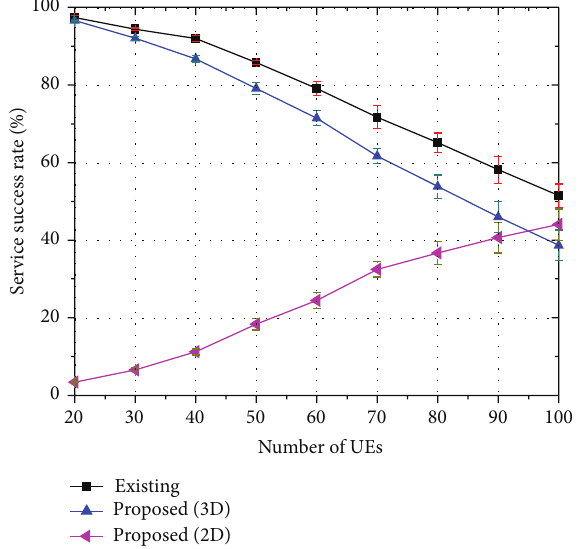
Figure 8: Service success rate of 16-viewpoint 3D A/V traffic ( 𝛽 = 0.9 ).